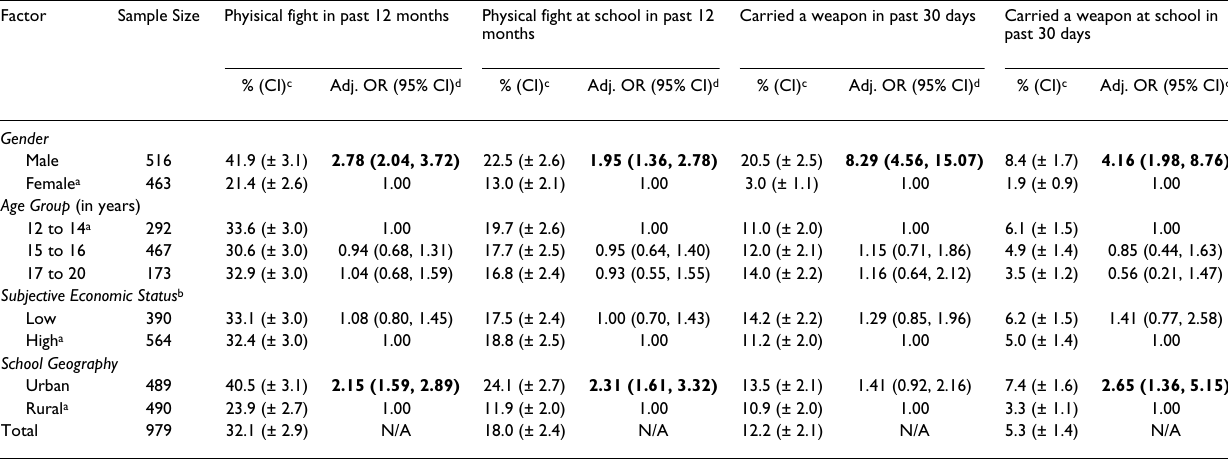
Table 1: Prevalence of aggressive behavior among eighth and ninth grade secondary students attending public schools in a central region of El Salvador by socio-demographic characteristics, 1999 Factor Sample Size Phyisical fight in past 12 months Physical fight at school in past 12 Carried a weapon in past 30 months